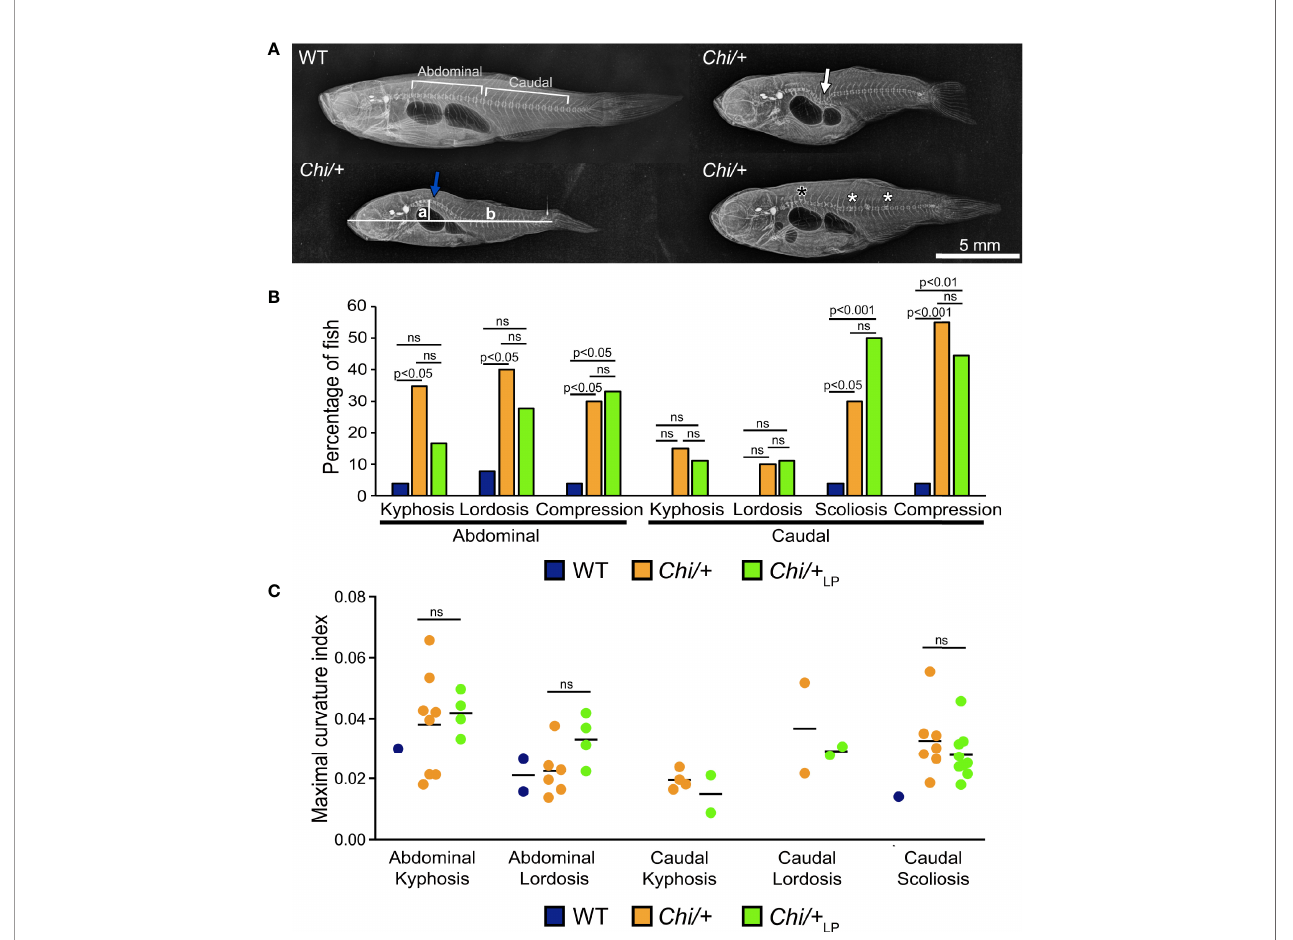
FIGURE 1 | Vertebral column deformities in Chi/+ and Chi /+ LP mutants. (A) Representative X-rays of three months old WT and Chi/+ (representative also for the malformations diagnosed in Chi /+ LP ) zebra fi sh show severe vertebral column deformities in mutants, i.e. abdominal kyphosis (blue arrow), abdominal lordosis (white arrow), vertebral body compressions (white asterisks) and hemivertebra (black asterisk). (B) Frequency of malformations. Chi/+ mutants (n=20) show increased frequency of kyphosis, lordosis, scoliosis and vertebral body compressions in the abdominal and caudal vertebral column compared to WT animals (n=26). Chi /+ LP animals (n=18) display reduced kyphosis and lordosis of the abdominal, but increased scoliosis of the caudal vertebral column. Alterations were diagnosed based on Alizarin red S whole mount-stained specimens; only the abdominal and caudal region of the vertebral column were considered for the analysis. Chi-squared test followed by Bonferroni correction; p values are indicated; ns: non-signi fi cant. (C) Severity assessment of the maximal curvature index diagnosed in WT, Chi/+ and Chi /+ LP related to abdominal kyphosis and lordosis, and to caudal kyphosis, lordosis and scoliosis. The graph shows individual data points and the mean value (black bar) for the maximal curvature index. The maximal kyphotic and lordotic indices were calculated in the sagittal plane of Alizarin red S stained specimens as the ratio (a/b) between the perpendicular distance from the axis (in correspondence of the maximal curvature, segment ‘ a ’ in A ) and the standard length (segment ‘ b ’ in A ). The same method but in the coronal plane was used to calculate the maximal scoliotic index. Mann-Whitney test was applied with a minimum of three values per group; ns, non-signi fi